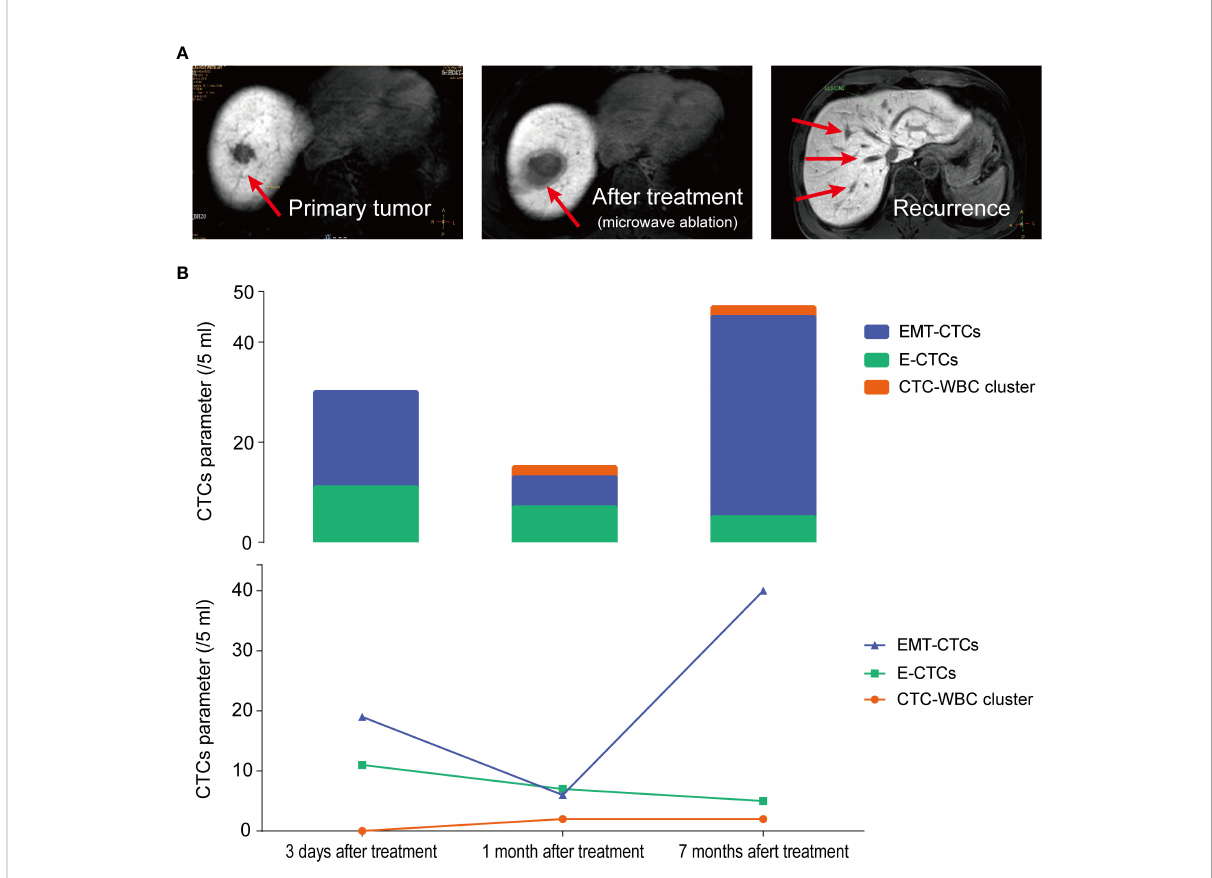
FIGURE 5 Longitudinal monitoring of total CTC count, EMT-CTC proportion, and CTC-WBC cluster in HCC patient K80570 who received microwave ablation. (A) The MRI images of the liver at 3 days, 1 month, and 7 months after microwave ablation treatment are presented. (B) Changes of E- CTCs, EMT-CTCs, and CTC-WBC cluster at pre-treatment, 1 month and 7 months after